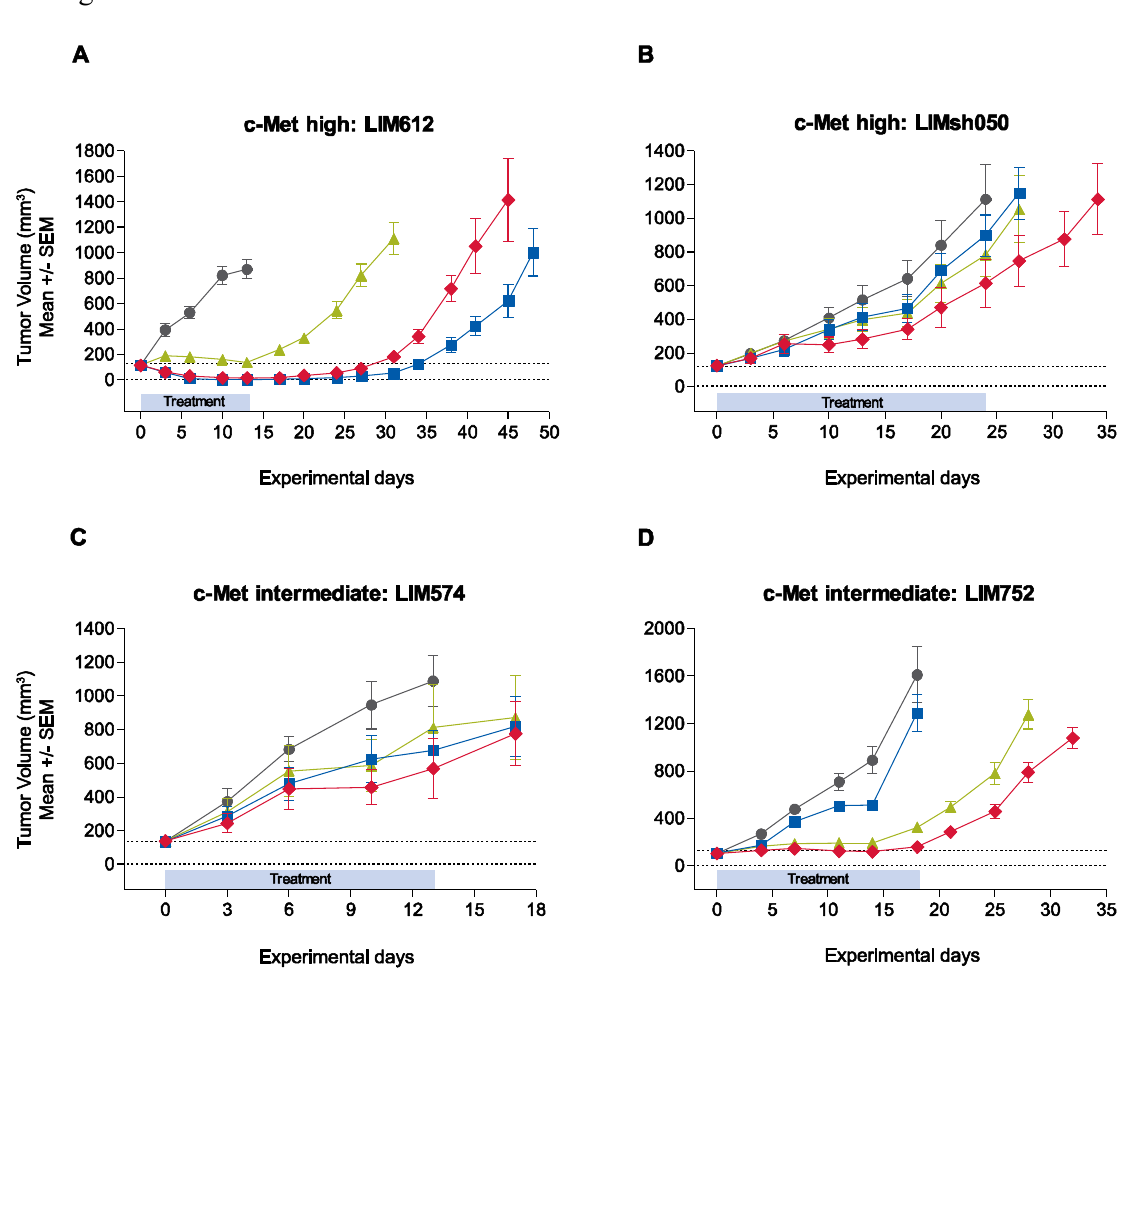
Figure 3. Representative examples of in vivo response kinetics of patient-derived HCC xenografts to MSC2156119J and